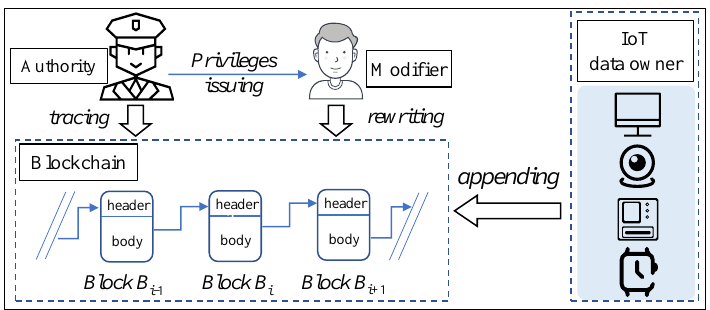
Figure 1. System model of PCHT-based redactable blockchain for